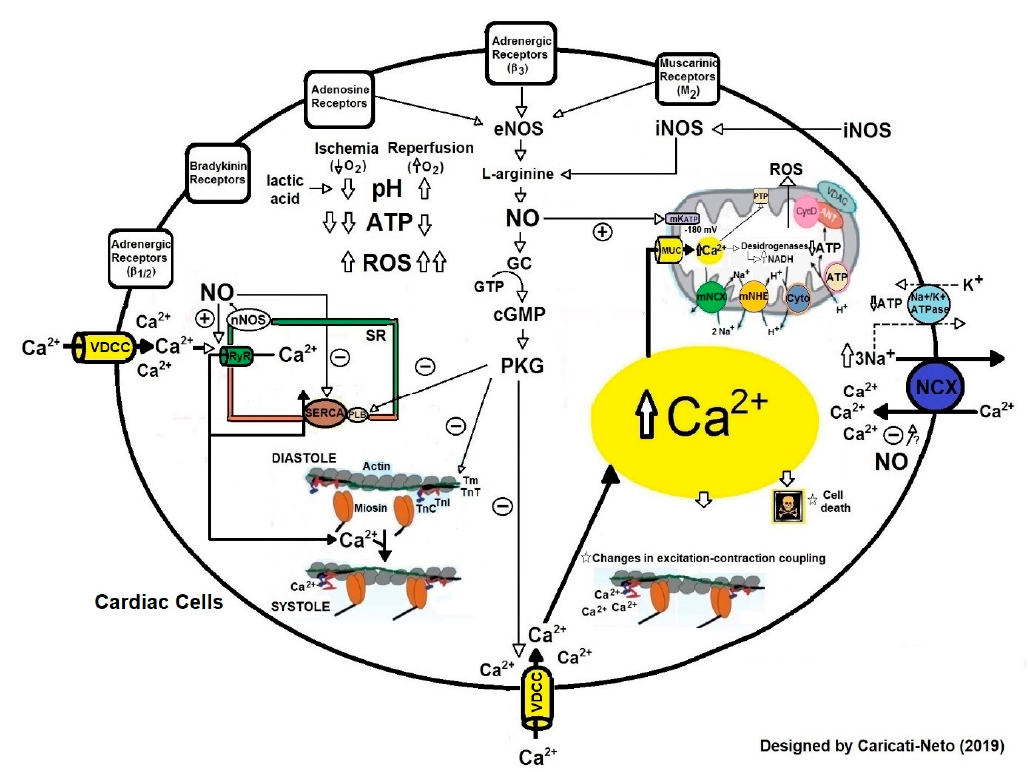
Figure 2. Molecular mechanisms involved in cellular dysfunctions caused by ischemia and reperfusion (I / R) injury in cardiac cells. During ischemia, intracellular accumulation of inorganic phosphate, lactate and H reduce intracellular pH, which increases NHE activity. ATP deficiency reduces the activity of ATP-dependent ion transport proteins, such as Na + / K + -ATPase, PMCA and SERCA, favoring Na + and Ca 2 + accumulation in the cytosol, which interferes with the plasma membrane NCX activity, worsening the cytosolic Ca 2 + overload. The Ca 2 + accumulation in cytosol compromises the mitochondrial membrane potential, leading to increased mitochondrial Ca 2 + uptake through the MCU, generating mitochondrial Ca 2 + overload. This Ca 2 + overload collapses mitochondrial function, altering ATP production. The cytosolic and mitochondrial Ca 2 + overload alters excitation-contraction coupling, and thus increasing the incidence of cardiac arrhythmias. In reperfusion, the cytosolic and mitochondrial Ca 2 + initiated in ischemia, additionally compromise oxidative phosphorylation and produce increment in the permeability of the internal mitochondrial membrane. This results in the production of free radicals that stimulate the opening of transition pores of mitochondrial permeability, releasing cytochrome C, which activates the apoptotic cascade. Increased production of free radicals causes structural damage and aggravates the cytosolic Ca 2 + overload, causing severe arrhythmias and cardiac collapse.